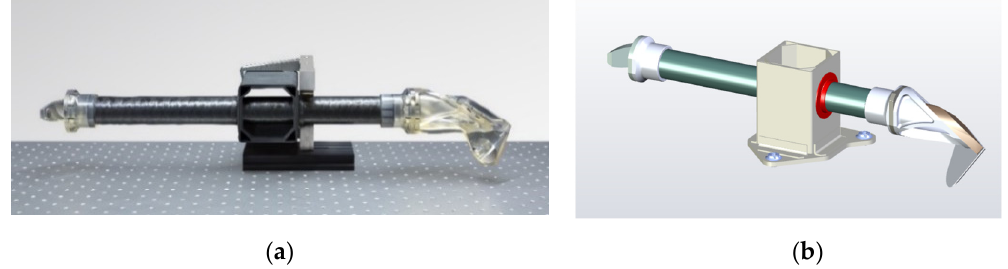
Figure 10. ( a ) Qualification model of the RRU of the LRI of GRACE-FO; ( b ) NGGM RRU concept with smaller beam separation and modified mounting interface.